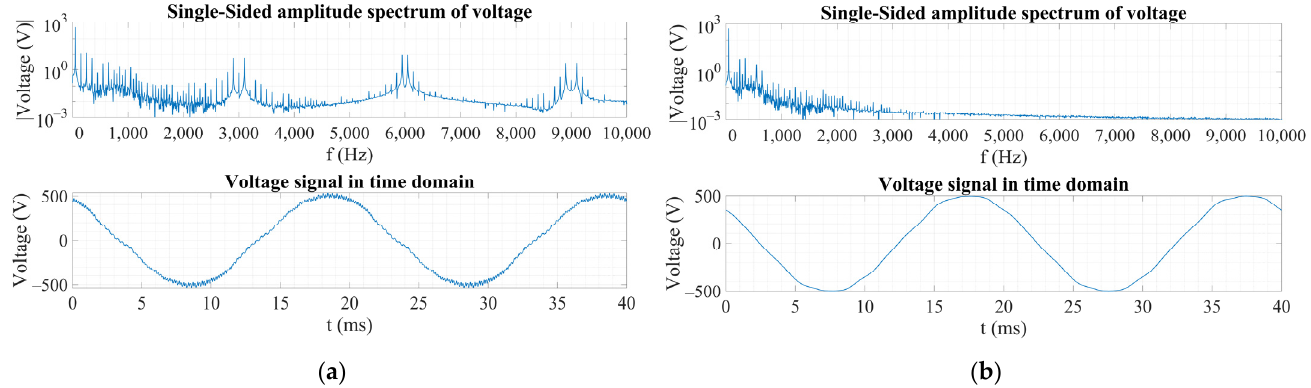
Figure 5. Single-sided amplitude spectrum of voltage and voltage signal in the time domain in the open-circuit test using ( a ) power converter and ( b ) regulating transformer.